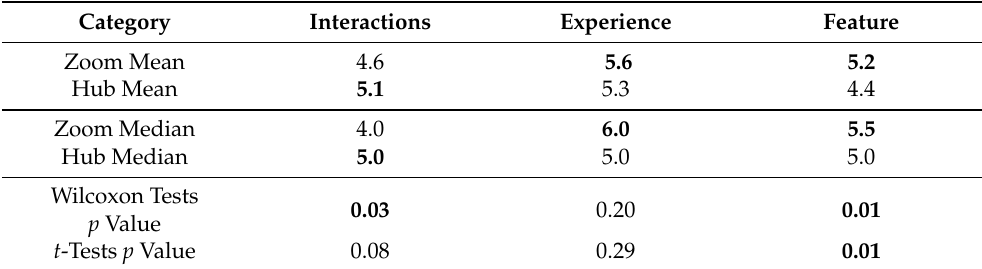
Table 1. Aggregated response result. Each category is the aggregated mean score for all questions in that section. Interactions are informal social interaction, Experience is learning experience, and Feature is Hub vs. Zoom features. Please see Appendix A. The higher values are in bold. Significant p values are also in